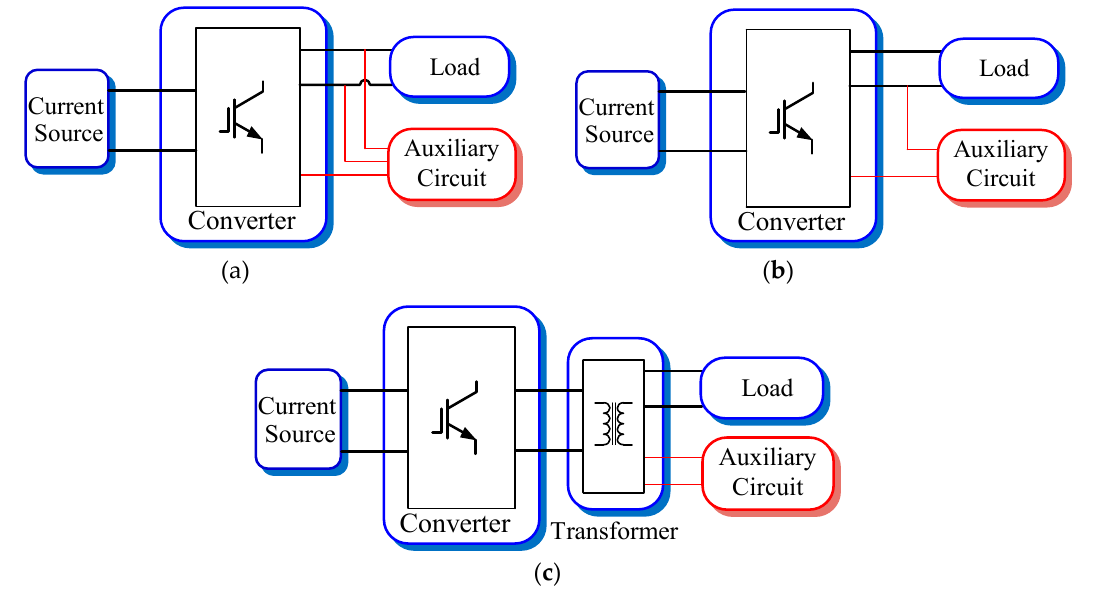
Figure 16. AC-side power decoupling circuit structure. ( a ) Share two bridge arms; ( b ) Share a bridge arm; ( c ) Three-port circuit.